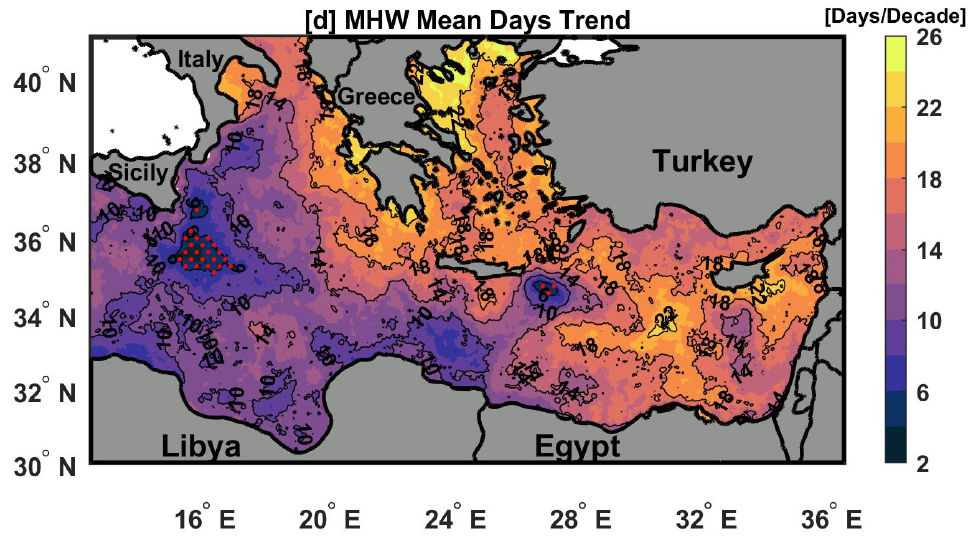
Figure 6. The trend maps of ( a ) AHW frequency, ( b ) MHW frequency, ( c ) AHW days, and ( d ) MHW days from 1982 to 2021 over the EMED region; the dotted red points show the non-significant ( p > 0.05) trend at 95% confidence level.